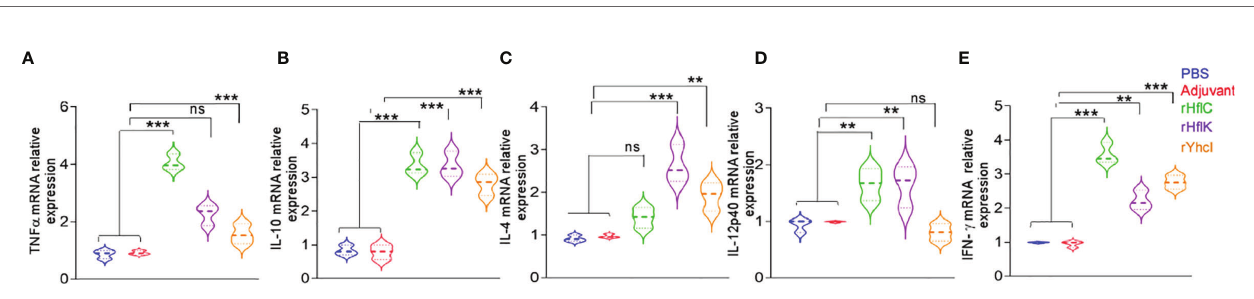
FIGURE 5 | Cytokine pro fi ling of the control and immunized mice. (A) TNF a , (B) IL-10, (C) IL-4, (D) IL-12p40, (E) IFN- g . The relative CT ( DD CT) method was used to quantify cytokine gene expression: CTs were normalized against the GAPDH gene CT ( D CT) and then compared to the same normalized gene in the PBS immunized mice group. The control groups were set to 1. ns, no signi fi cance, **P < 0.01, ***P < 0.001. x-axis: Study groups, y-axis- Relative gene expression (fold).